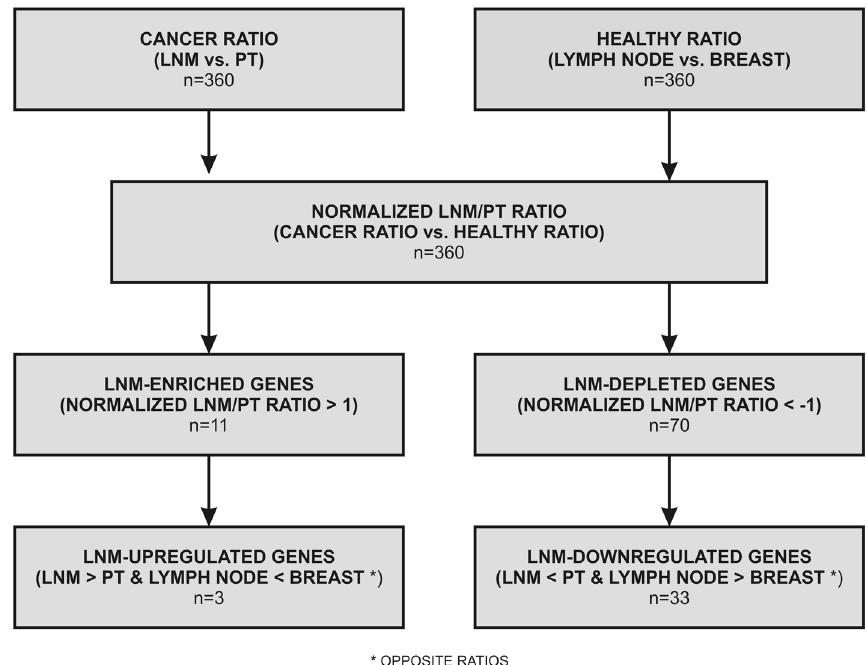
Figure 1. General flow of data analysis. 360 genes were analysed in 11 matched pairs of PT and LNM tissues (CANCER; NanoString data) with a healthy-background normalization based on expression data for healthy breast and lymph node tissues (HEALTHY; Illumina Body Map data); for each gene, normalized LNM/PT ratio was calculated for each matched LNM-PT pair separately, and the median of all normalized LNM/PT ratios was employed in further